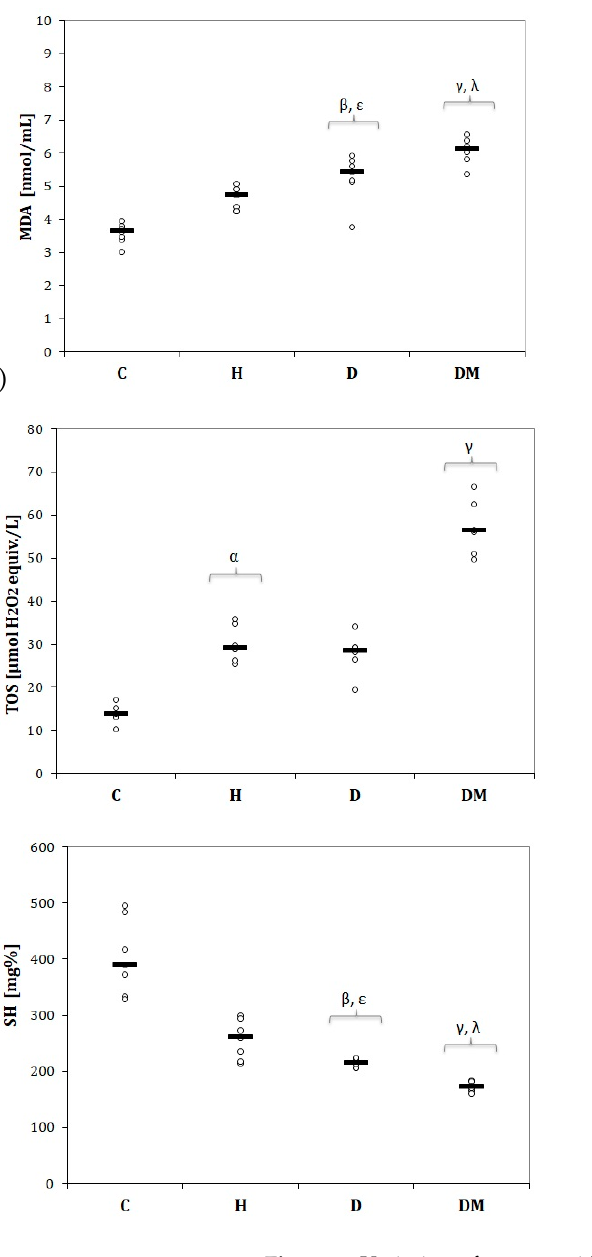
Figure 5. Variation of serum oxidative stress by groups of: ( a ) Malondialdehyde (MDA); ( b ) Nitric oxide (NOx); ( c ) Total oxidative status (TOS); ( d ) Total antioxidant capacity (TAC); ( e ) Thiols (SH); ( f ) Oxidative stress index (OSI). C = Control group, H = Hypertension group, D = Dyslipidemia group, DM = Type 1 Diabetes Mellitus group. The letter codes correspond to the Kruskal-Wallis post-hoc p -values: α H compared to C (0.035 NOx, 0.047 TOS, 0.047 OSI), β D compared to C (0.012 MDA, 0.020 TAC, 0.012 SH), γ DM compared to C (<0.001 MDA, TOS, TAC, SH, OSI), λ DM compared to H (0.049 MDA, <0.001 NOx, 0.011 TAC, 0.025 SH), µ DM compared to D (0.037